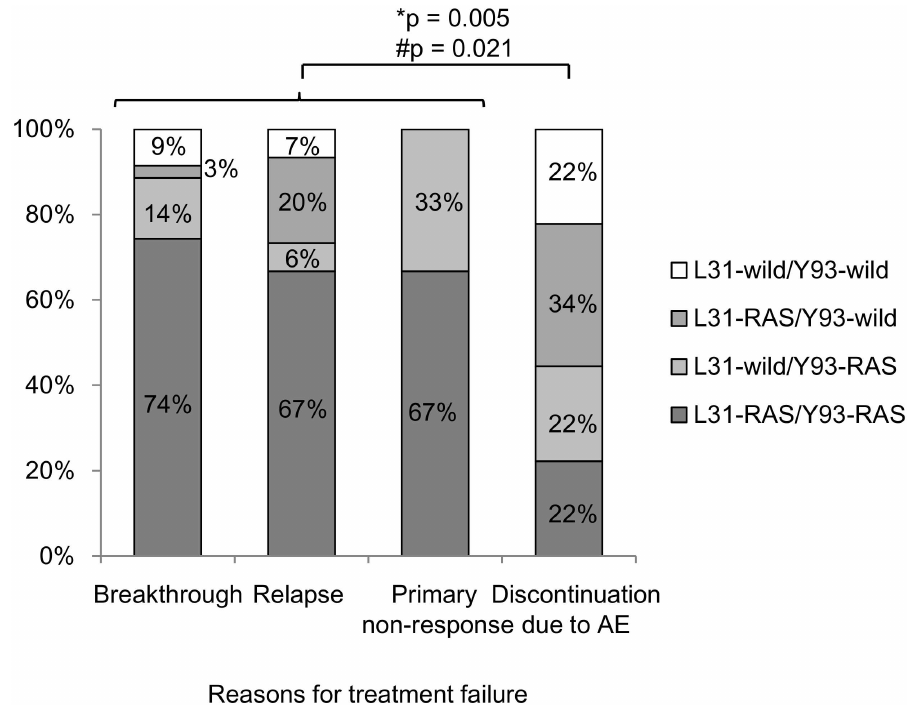
Fig 4. Prevalenceof signature RASs in NS5A in terms of reasons for treatment failure. The prevalence of signature RAS at L31 and/or Y93 in NS5A in patients who stopped the therapy by adverse events was significantly low than others.